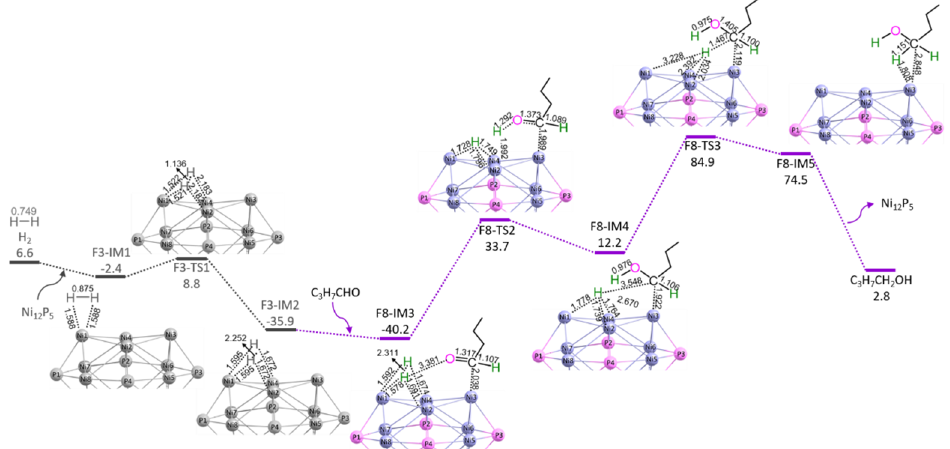
Figure 8. The potential energy curves with the relative Gibbs free energy ( G r , kJ mol − 1 ) and the geo- metric structures with bond lengths (Å) for reaction stage S8 over Ni 12 P 5 cluster at GGA − PBE/DSPP, DNP level. For brevity, some hydrogen atoms are hidden.